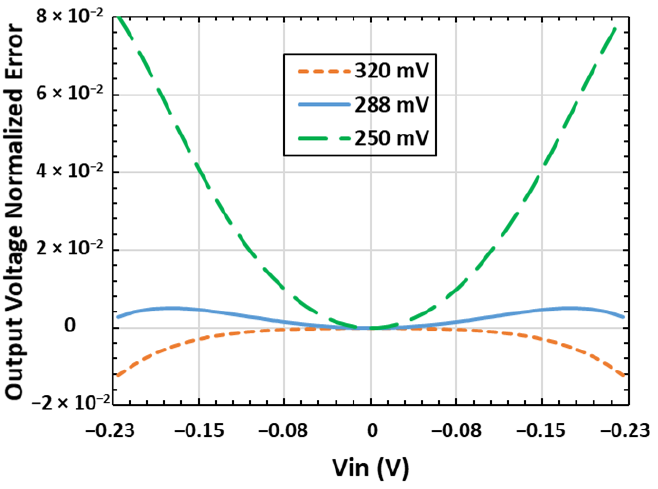
Figure 4. Relative non-linearity error of the second-stage buffer for different values of v corr .